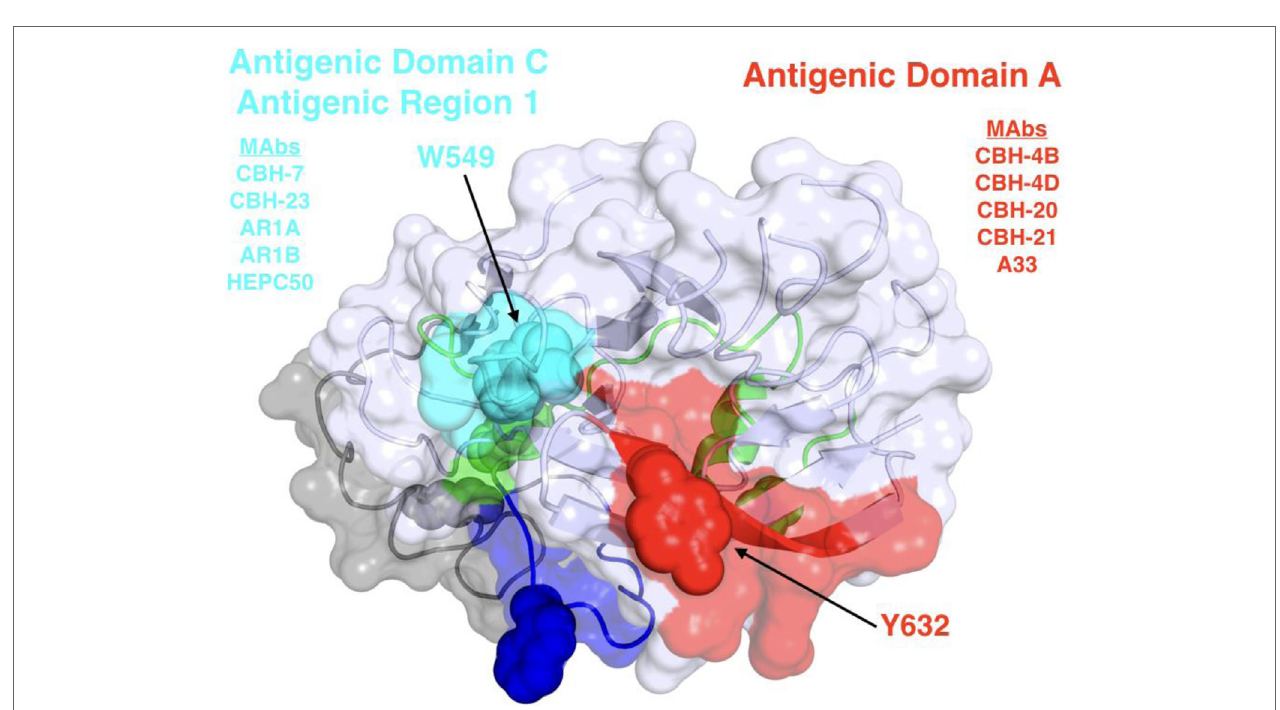
FiGURe 2 | Structure and mapped epitope sites on the back layer and proximal β sandwich residues of E2. The structure corresponds to a distal face of the E2 core structure shown in Figure 1 , with antigenic domains/regions labeled and representative monoclonal antibodies listed.